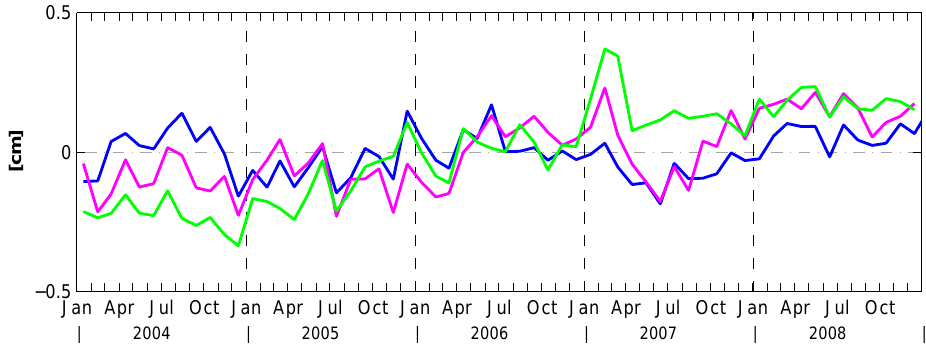
Fig. 3. GSSL anomaly (60 ◦ S–60 ◦ N, 10–1500m) during 2004–2008 based on three different gridded fields, i.e. ARIVO (green, Argo plus other data, Ifremer), from Scripps Institution of Oceanograph (blue, Argo only) and MOAA (red, Argo plus other data, Japan Agency for Marine-Earth Science and Technology). The data have been downloaded from the Argo web page